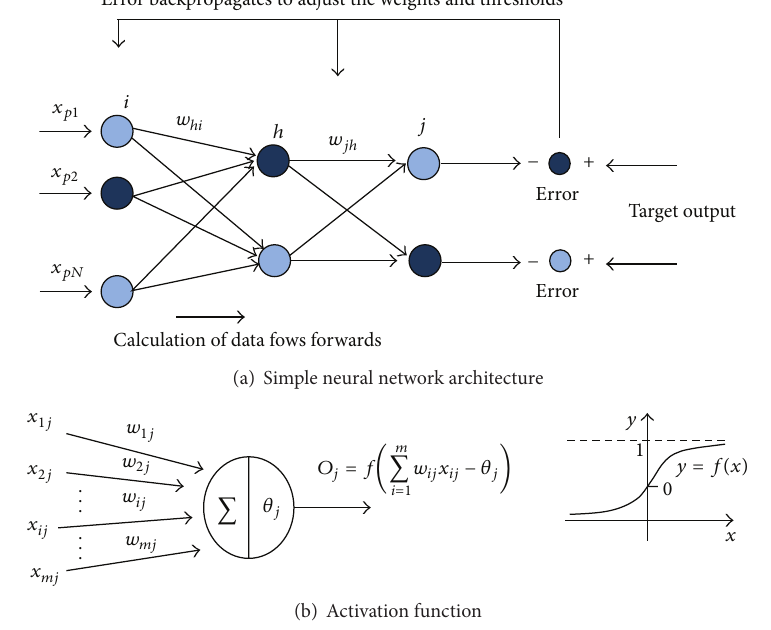
Figure 2: Schematic diagram for simple NNA architecture [22, 24].